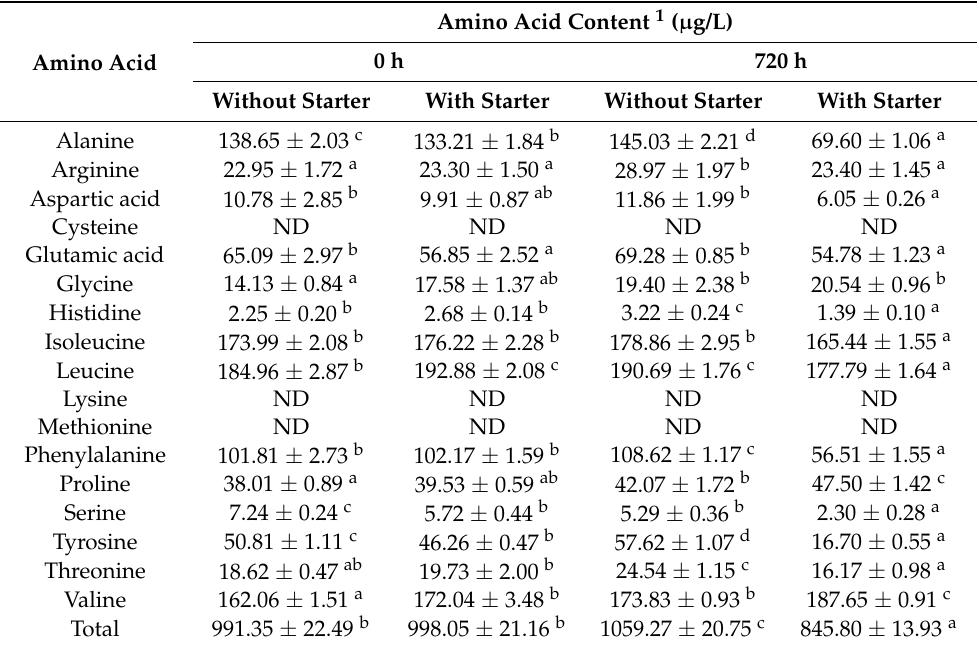
Table 1. Total amino acid and free amino acid content of a fermented mushroom beverage (FMB) with and without starter culture L. plantarum SK15 during fermentation time at 0 h and 720 h. Amino Acid Content 1 ( µ g/L) 0 h 720 h Amino Acid Amino Acid Without Starter With Starter Without Starter With Starter